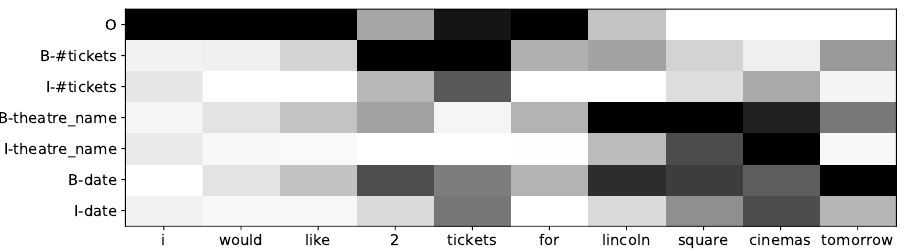
Figure 4. Potential scores with only node potentials in eCRFs for the cross-domain task. The darker the color, the higher the potential